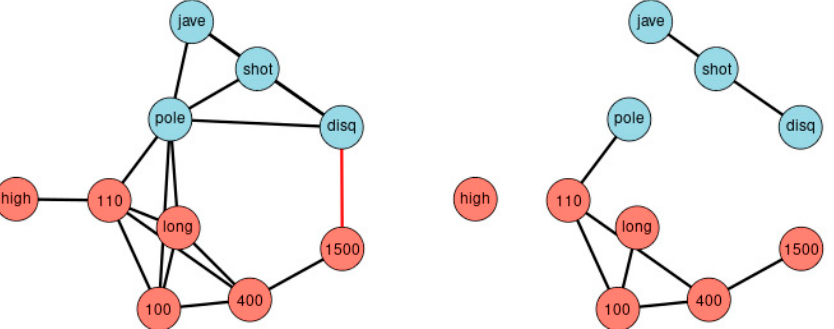
Figure 3. Network of agreement between the disciplines. The network consists of nodes and edges obtained from Figure 2, and depicts all correlation beyond thresholds of |r| > 0.3 (left) and |r| > 0.5 (right). The approach highlights the importance of choosing the appropriate threshold. Blue nodes represent disciplines involving upper parts of the body, red nodes disciplines focus on the lower part of the body. Black edges indicate positive, red edges indicate negative correlations.